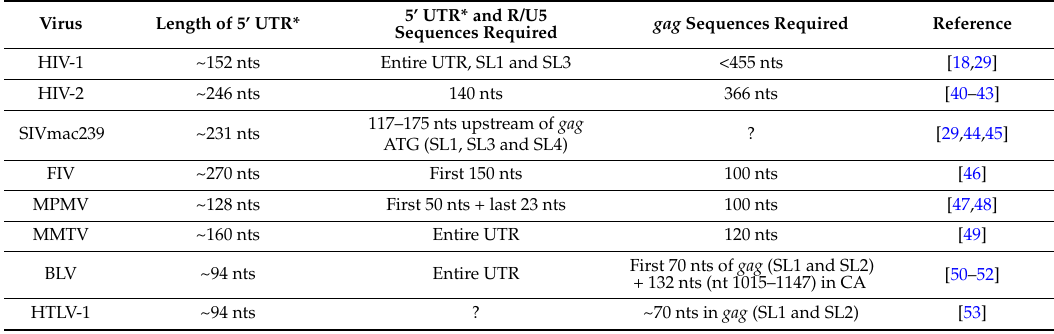
Table 1. Summary of the packaging determinants mapped to the R/U5, 5’ untranslated region (5’ UTR)* and gag gene of different